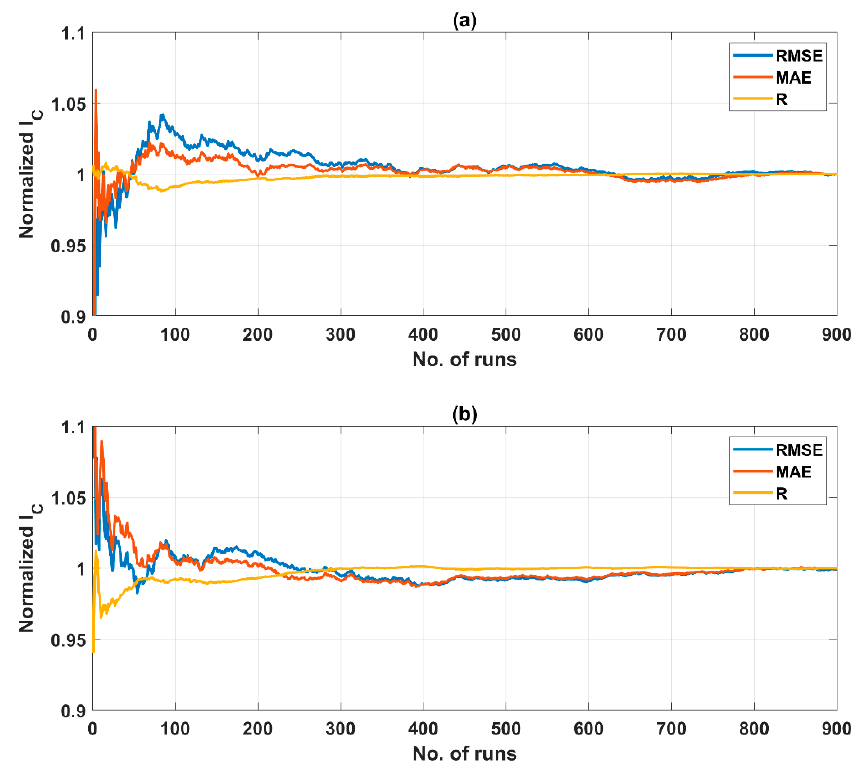
Figure 9. Statistical results of RMSE, MAE, R over 900 Monte Carlo simulation using SVM in case of: ( a ) Normalized I C for predicted MF; ( b ) Normalized I C for predicted MQ.